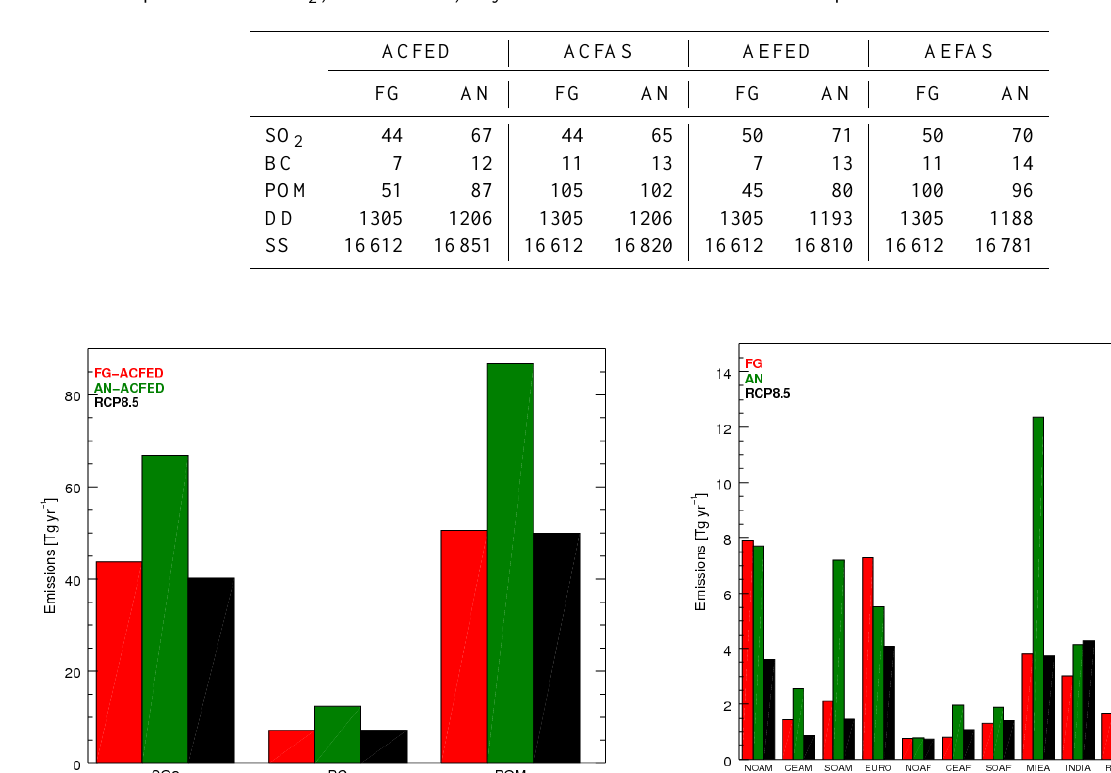
Table 3. Total FG and AN annual emissions in TgSyr − 1 for SO 2 and Tgyr − 1 for the other aerosol species for the year 2010 and each one of the four experiments. For SO 2 , BC and POM, only the fluxes of the active variables are provided.